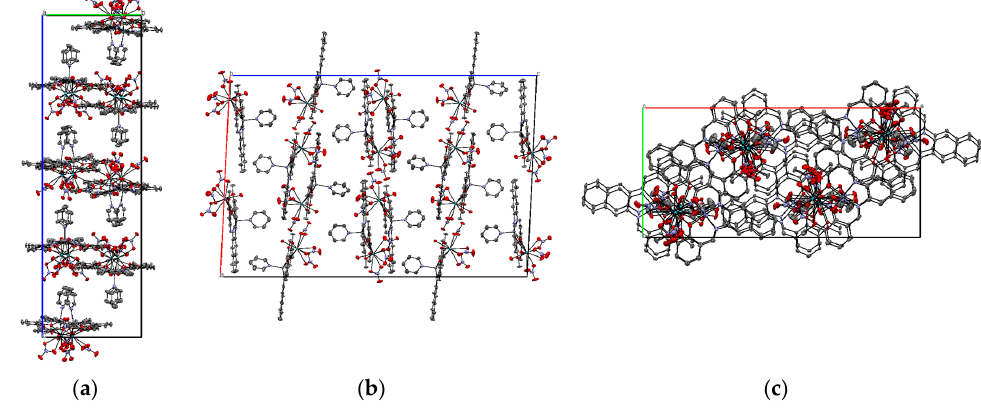
Figure 2. Crystal packing of ( 3 ) shown along ( a ) the a -axis; ( b ) the b -axis; and ( c ) the c -axis. 50% probability ellipsoids, H-atoms and solvate molecules omitted.